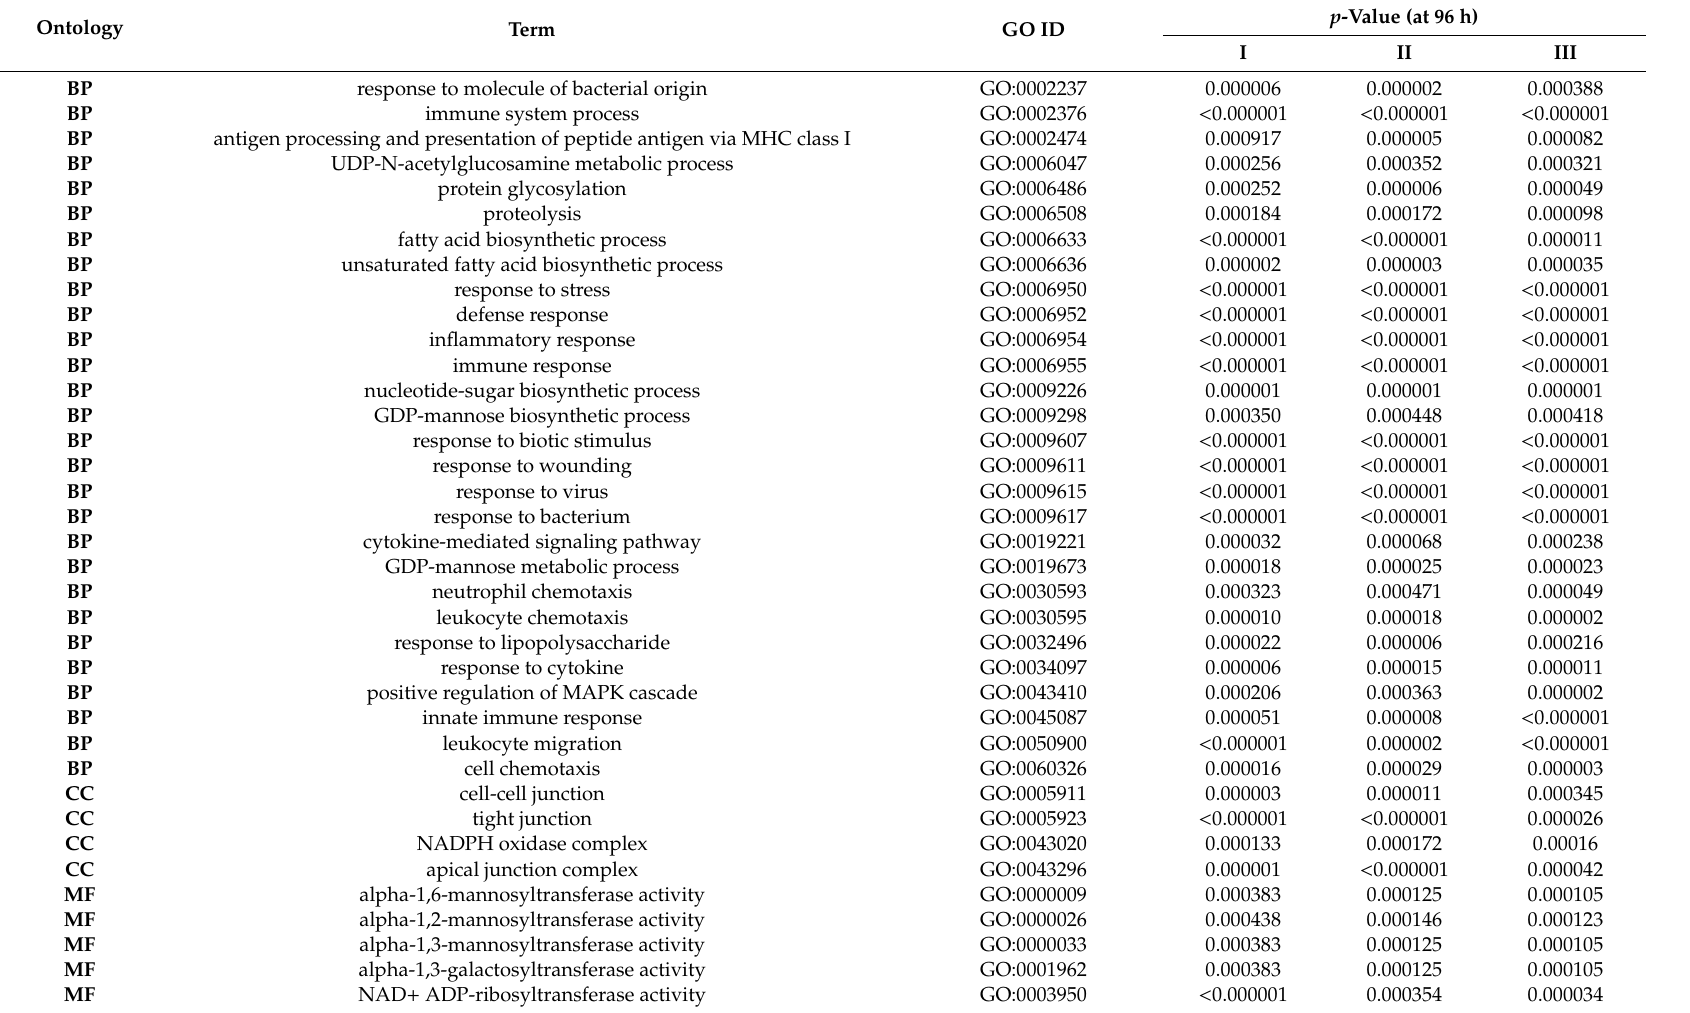
Table 1. Significantly a ff ected gene ontologies (GOs) after PHMG-P exposure to zebrafish embryo /